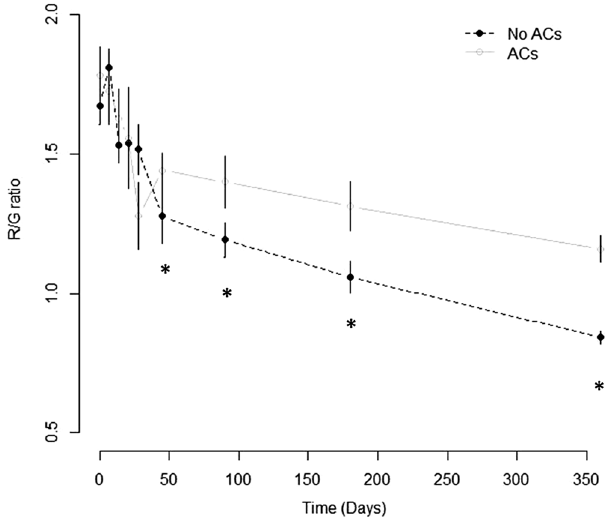
Figure 2. Mean R/G ratio and relative 95% error bands at baseline, POD7, POD14, POD21, POD28, POD45, 3 months, 6 months and 1 year after LuTx for the two study groups. Asterisks (*) indicated time-points with significant differences between two groups.